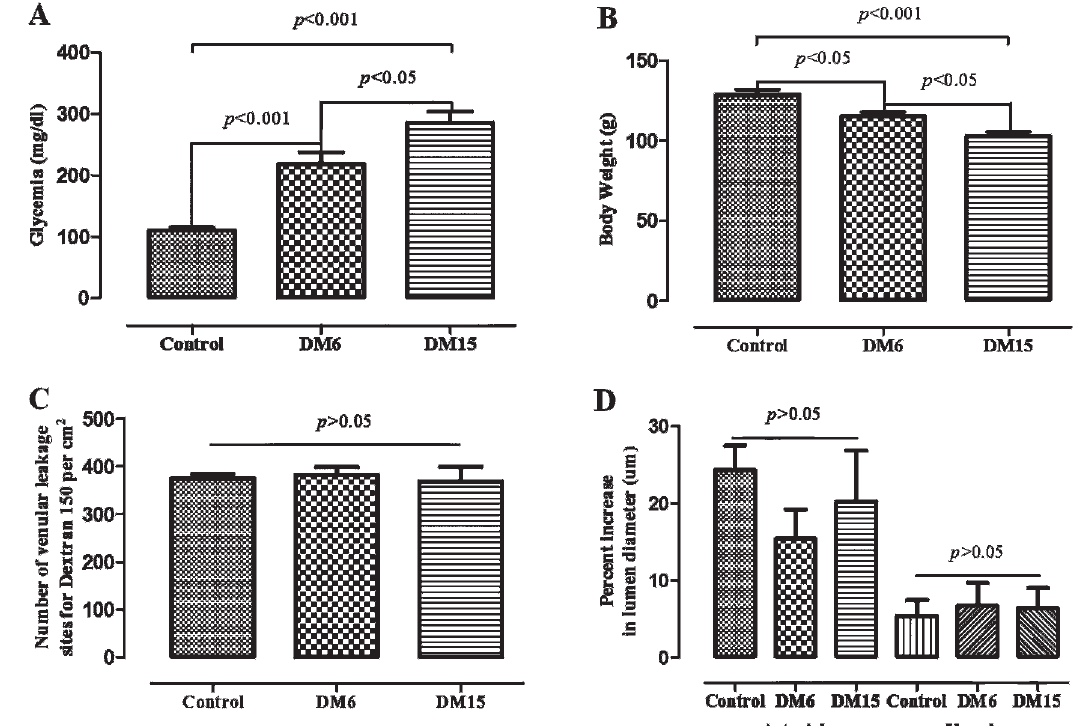
Figure 1 - The mean ¡ the standard error of the mean (SEM) for glycemia, body weight, and microvascular responses to histamine and acetylcholine in age-matched controls and hamsters at 6 (DM6) and 15 days (DM15) after the induction of diabetes with streptozotocin (STZ, 50 mg/kg). Statistical significance was determined using one-way ANOVA followed by Tukey’s post-hoc analysis. A . Glycemia (mg/ dl): p , 0.001 for the control group vs. both DM6 and DM15, and p , 0.05 for the DM6 group compared with the DM15 group. B . Body weight (g): p , 0.05 for the control group vs. the DM6 group, p , 0.001 for the control group vs. the DM15 group, and p , 0.05 for the DM6 group vs. the DM15 group. C . Microvascular responses (number of dextran 150kDa leakage sites per cm 2 ) to histamine (10 -6 M). There were no significant differences between the groups ( p . 0.05). D . Responses (as percent increase in lumen diameter) of arterioles and venules to topical application of acetylcholine. There were no significant differences between the groups ( p . 0.05).